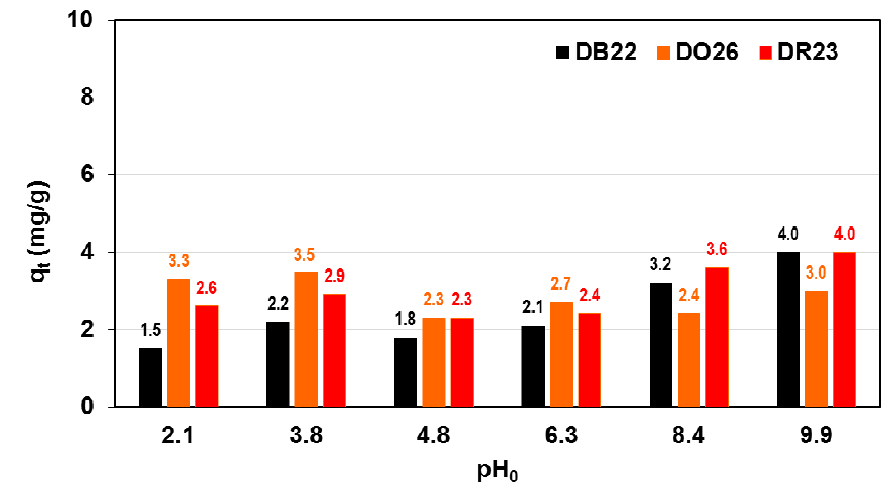
Figure 7. Direct dye adsorption on the A21 weakly basic resin as a function of solution